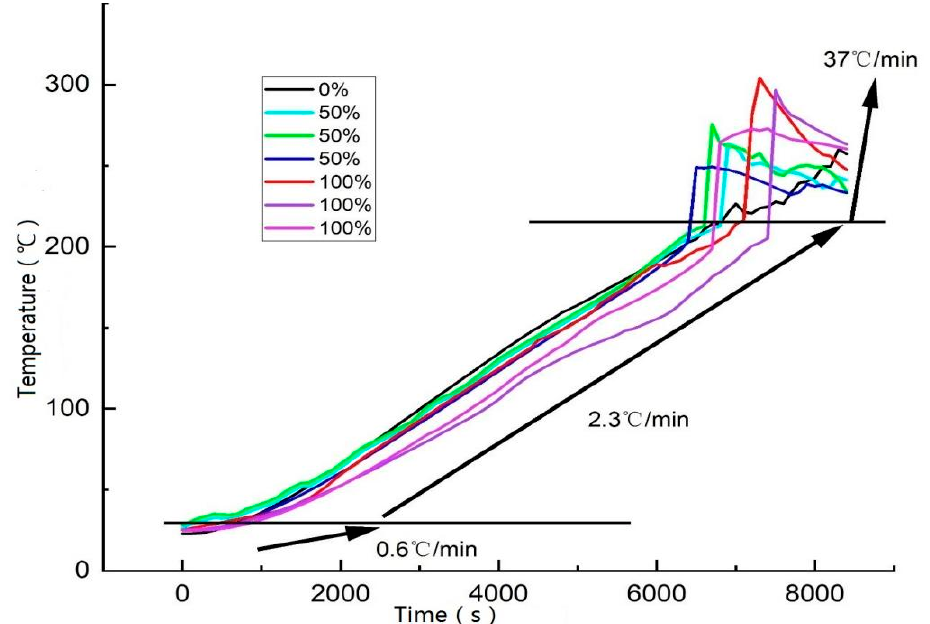
Figure 4. Temperature rate of the cell versus cell temperature. Overview of the entire experiment duration. A fresh cell at 100%, 50%, and 0% SOC shows the temperatures measured on the cell surface. The rate of temperature rise is divided into three stages, 0.6 °C/min, 2.3 °C/min, 37 °C/min.